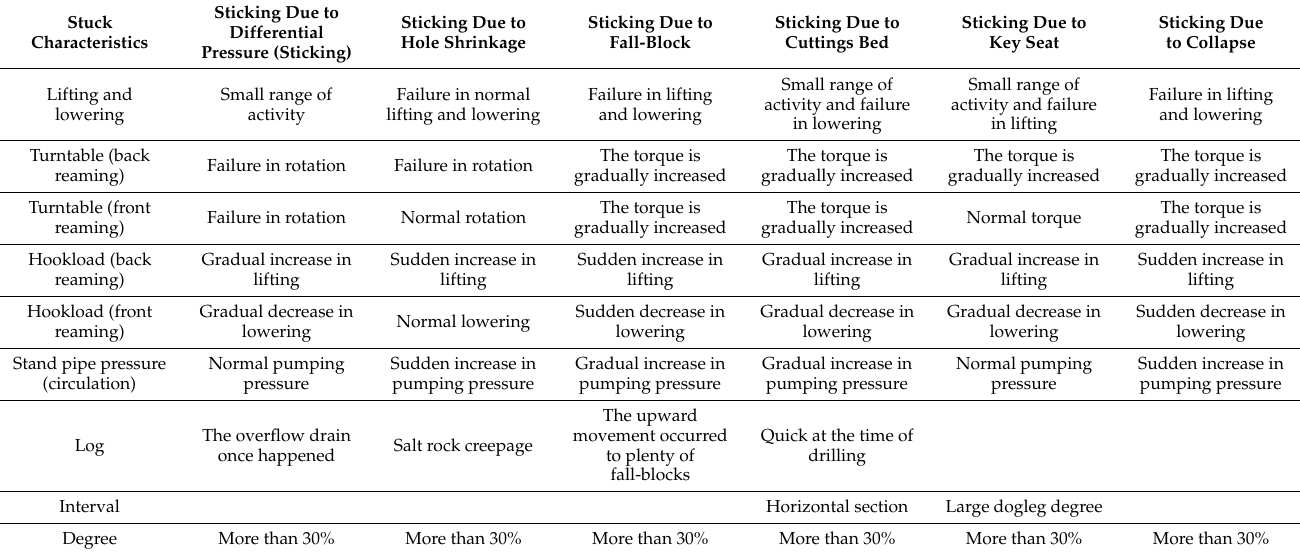
Table 5. Mechanism and rule of different types of